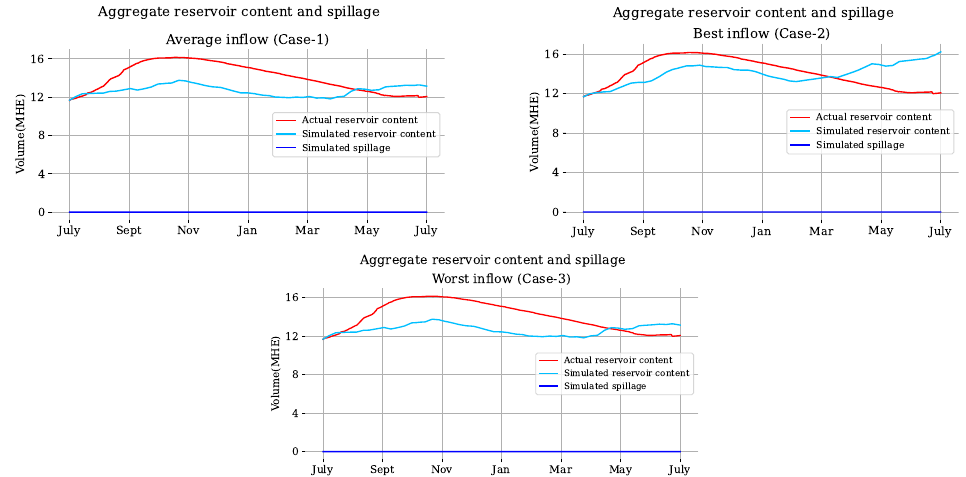
Figure 15. Actual reservoir content plus simulated reservoir contents and spillage for the tree cases.